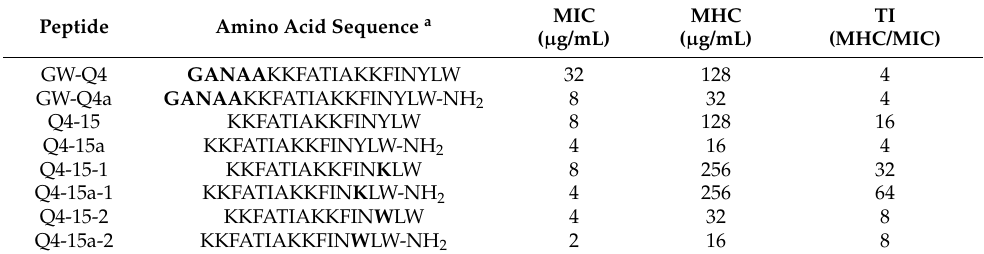
a Boldface type indicates amino acid residues truncated or substituted in the Q4